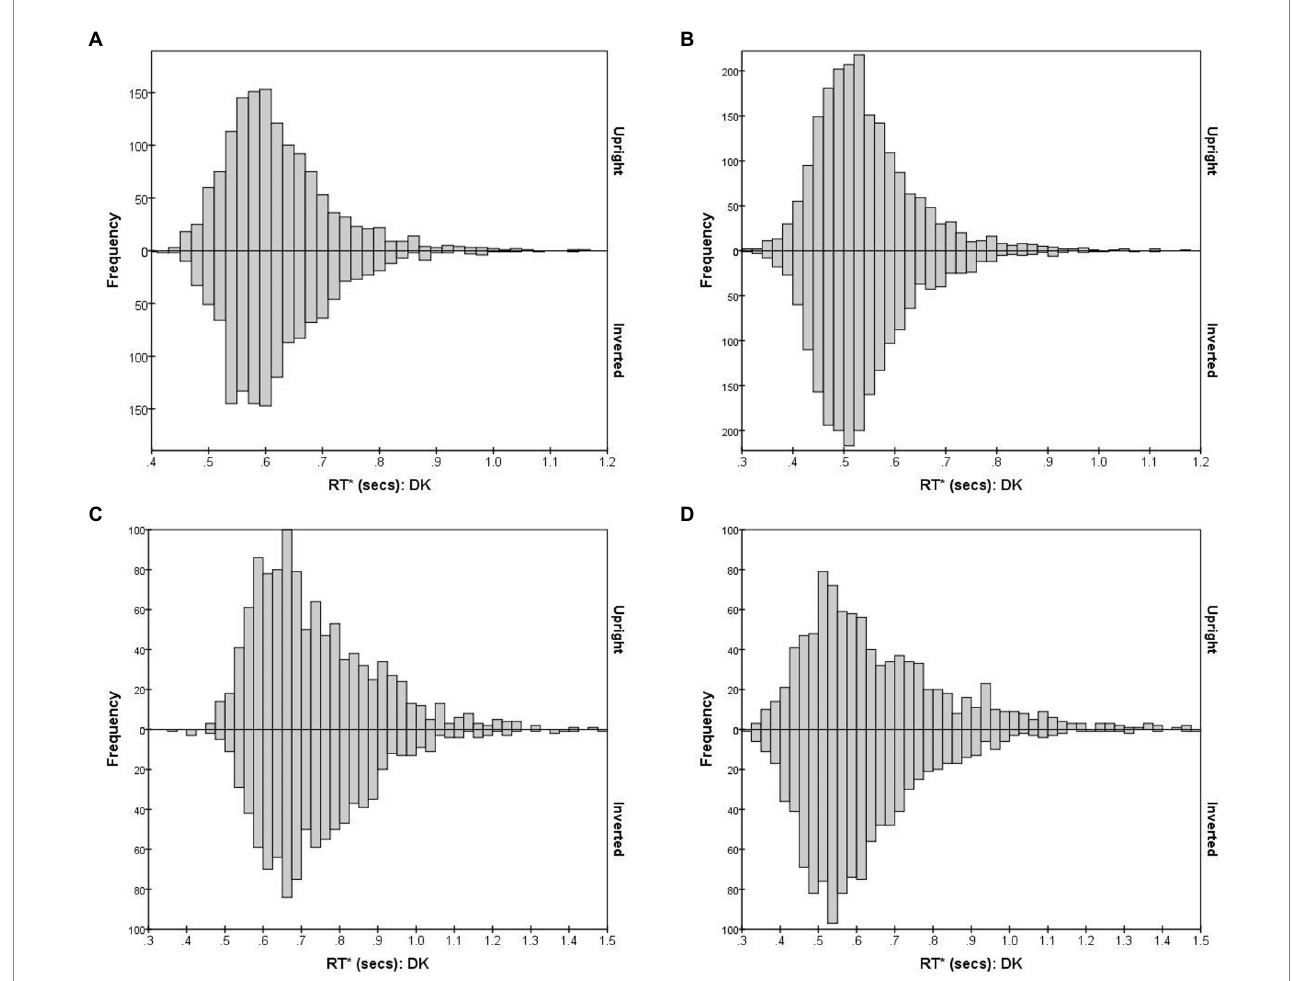
FIGURE 4 RT*( i,j ) distributions for observer DK, for FE pairs presented Upright (positive values on the y -axis) and Inverted (negative values on the y -axis). The four graphs illustrate RT* ( i,j ) distributions for pairs that vary in the degree of inter-stimulus similarity. (A) S responses for 15 identical pairs; (B) D responses for 10 most-different pairs; (C) S responses for 10 intermediate-similarity pairs; (D) D responses for 10 intermediate-similarity